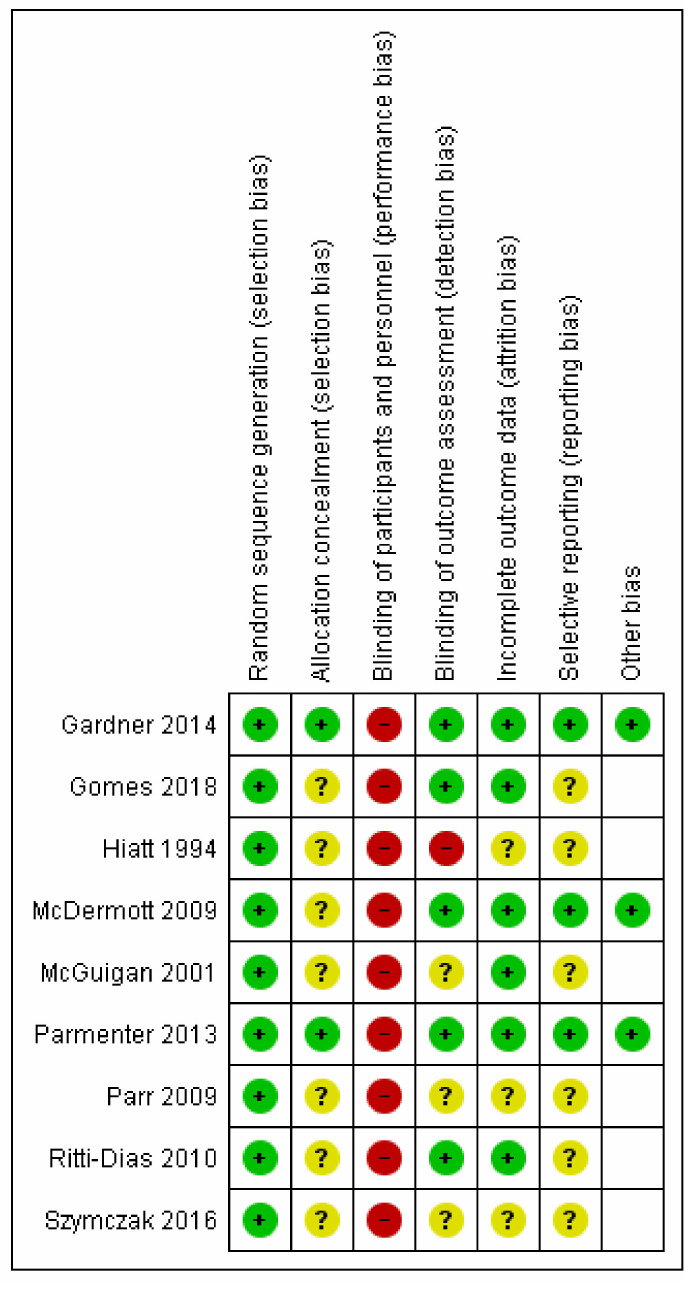
Figure 2. Risk of bias summary per included study